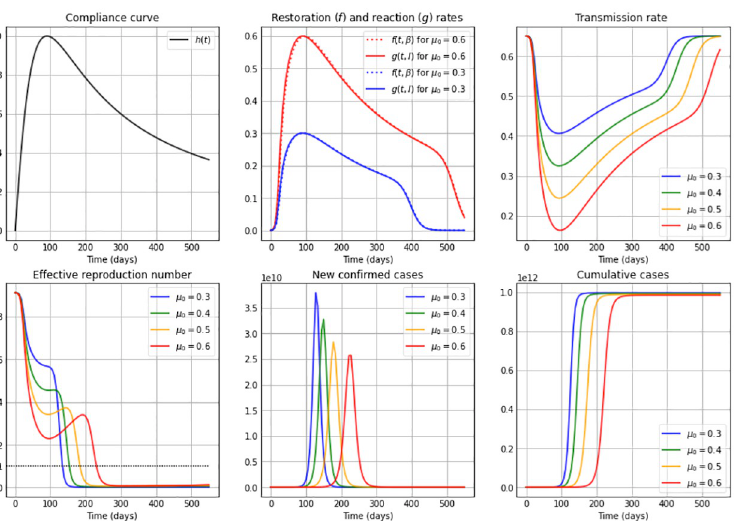
Fig 4. Simulations for a high restoration coefficient ν = 0.8. The first subplot depicts the shape of the compliance curve h ( t ) = ( a + 2 b ) t /( t 2 + at + b 2 ), with b = 90, a = 40, and the second plot in the first row illustrates the restoration rate f ( t , β ) (dotted) and the reaction rate g ( t , I ) (solid). The remaining subplots show: The transmission rate β ( t ), the effective reproduction number R ð t Þ , the new confirmed cases eE ( t ), and the cumulative cases E ( t ) + I ( t ) + R ( t ). The e maximum value μ 0 of the reaction coefficient ( μ ( t ) = μ 0 h ( t )) used in each subplot is: μ 0 : 0.3 (blue); 0.4 (green); 0.5 (orange) and 0.6 (red), and the remaining parameter values and initial conditions are as in Table 2.